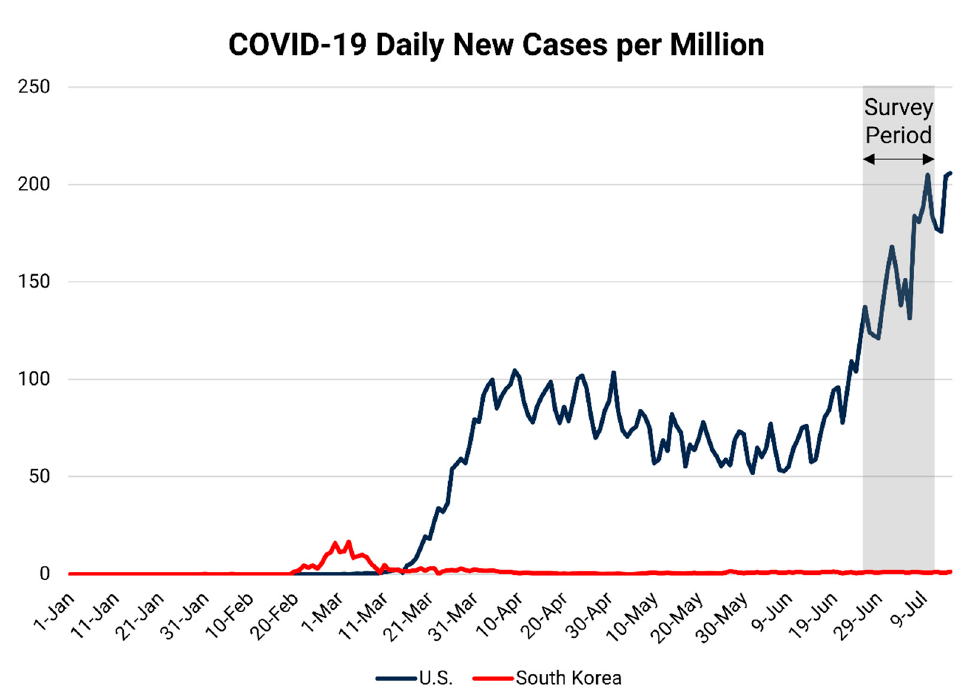
Figure 2. COVID-19: daily new cases per million in the U.S. and South Korea since January 2020 (data source: [34]).